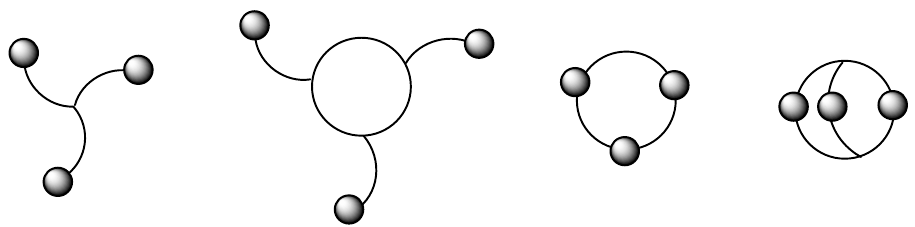
Figure 2. Representation of the different C3 topologies [3].